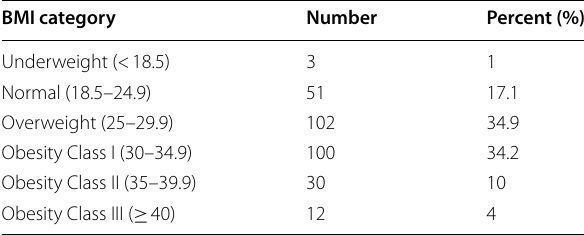
Table 2 Obesity distribution among the study population